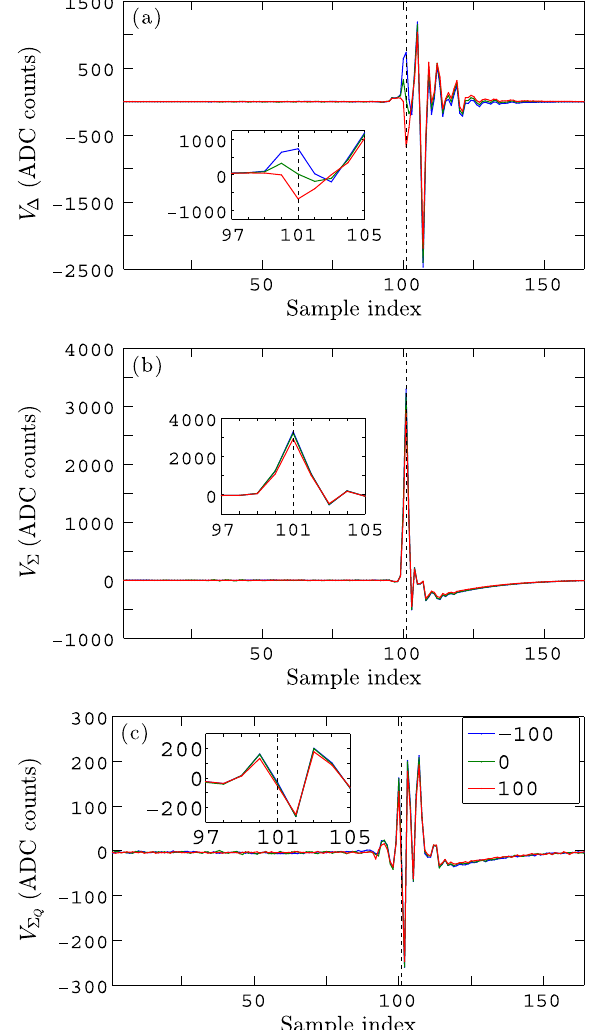
FIG. 16. Example recorded (a) V Δ , (b) V Σ , and (c) V Σ waveforms for three illustrative vertical beam position settings: − 100 μ m, 0 μ m and 100 μ m (set using the BPM vertical mover). The bunch sample, as indicated by the vertical dotted line, is set to correspond to the peak of the V Σ signal. A zoom of the region around the bunch sample is shown inset for each signal. Note that the large negative peak six samples after the bunch sample in (a) is due to round-trip reflections through the striplines arriving back at the input ports of the